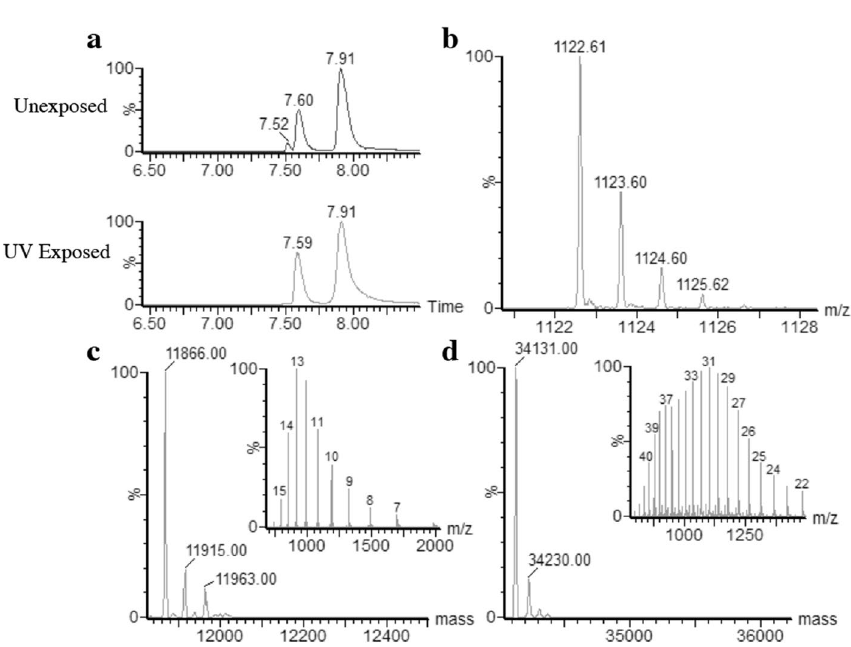
Figure 3. Characterization of HLA-E/pUV peptide G2 complexes by mass spectrometry. The photosensitive monomer HLA-E/pUV peptide G2 was injected onto a C18 column to analyze its components. ( a ) LC profiles of the monomer before and after UV exposure. ( b ) Mass spectrum analysis of the G2 peptide eluted in the 7.52 min peak of the unexposed monomer LC profile. ( c ) ( d ) Deconvoluted mass spectra obtained from the analysis of the chromatographic peak at 7.6 min ( c ) and 7.9 min ( d ) with mass spectra in